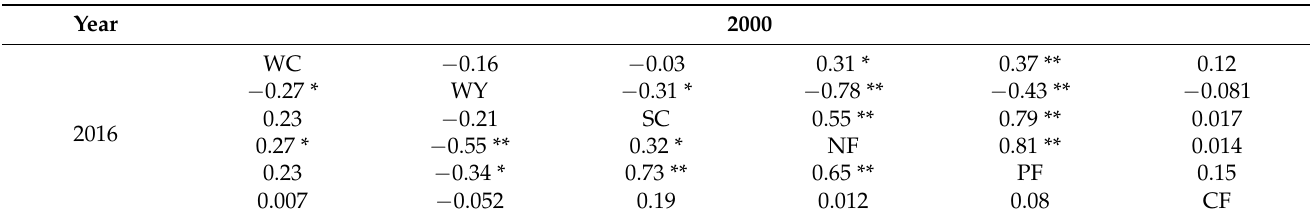
Table 3. Change Matrix of the Spearman Correlation Coefficient between Different ESs from 2000 to 2016.